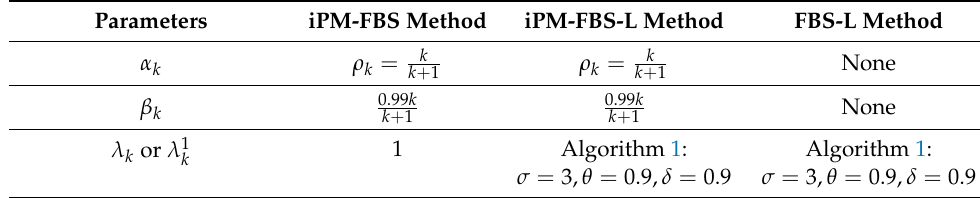
Table 4. Details of parameters for each method.